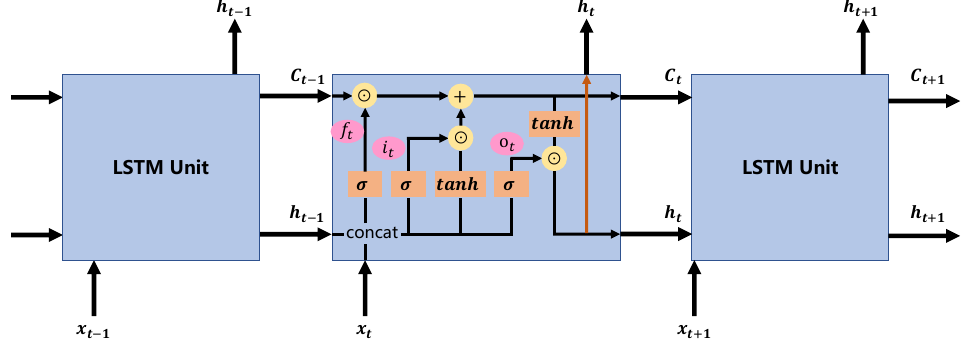
Figure 3. The structure of LSTM model, where x t is the input of time-step t , h t is the output of time-step t , and C t is the cell state of time-step t . The operations in the yellow circles are pointwise operations, where + represents matrix addition, and (cid:12) represents Hadamard product, i.e., the multiplication of the corresponding elements of two matrices. The orange rectangles represent network layers, where σ is the sigmoid active function, and tanh is the tanh active function. f t , i t , and o t are the output of forget gate, input gate, and output gate of time-step t , respectively. concat represents the operation of concatenating the matrices of x t and h t − 1